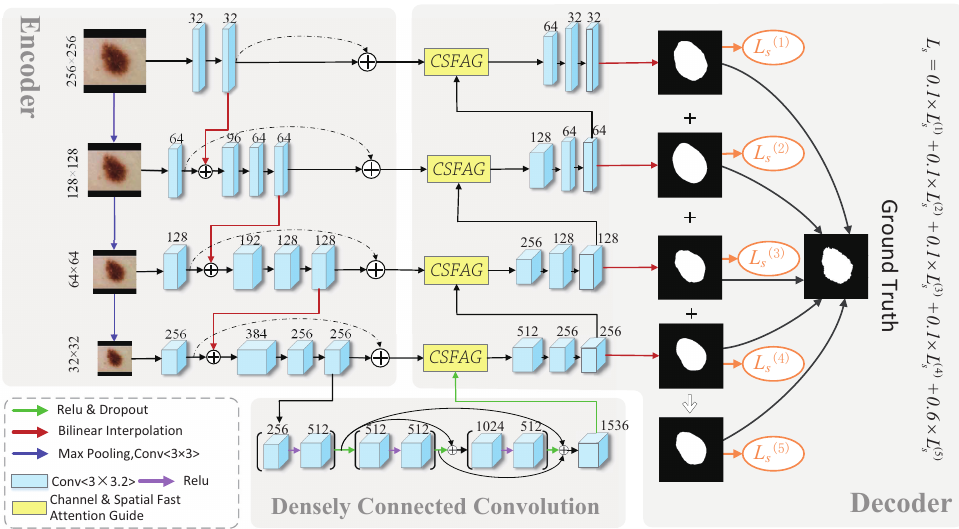
Figure 2. CSAG and DCCNet model architecture.